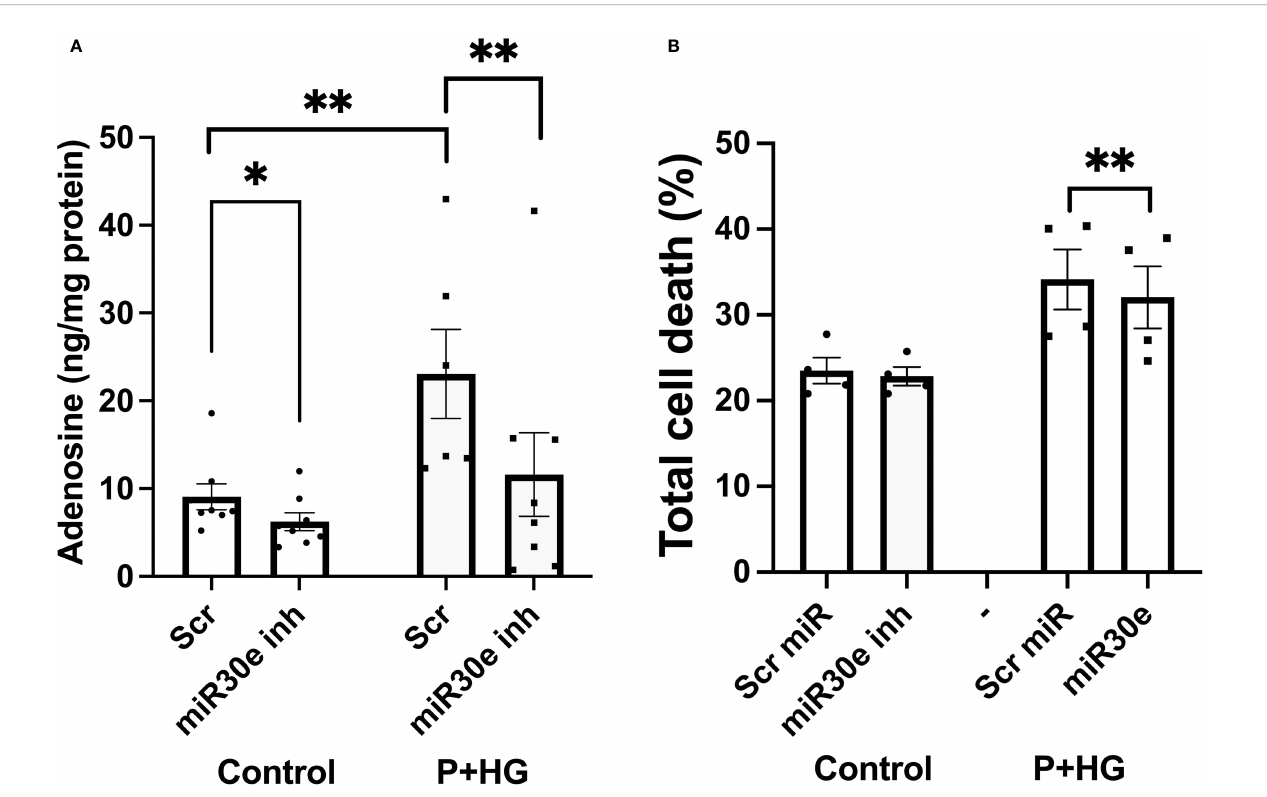
FIGURE 8 Inhibition of miR-30e-3p binding to the ADA1 3 ’ -UTR leads to decreased intracellular levels of adenosine and improved cell survival EndoC-betaH1 cells were pre-treated for 30 hours with 400 nM of the miR-30e-3p target site inhibitor and then exposed to palmitate + high glucose (P+HG) over night (A) . Intracellular adenosine levels were analysed using an ELISA and expressed per mg protein. (B) Cells were treated as in (A) and then analysed by fl ow cytometry for quanti fi cation of Annexin V and PI positivity. Results are total cell death rates, i.e. the sum of the percentages Annexin V and PI positive